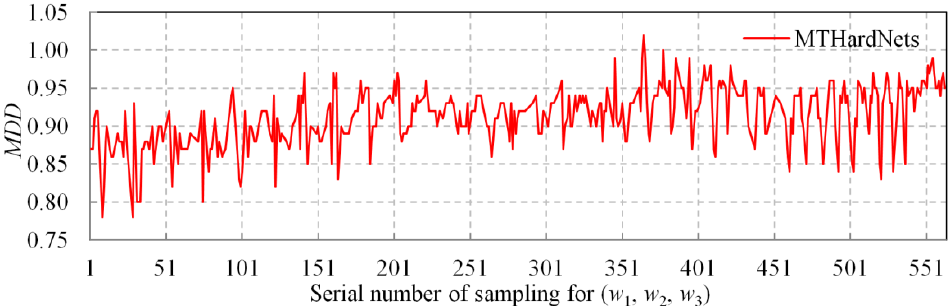
Figure 5. The MDD comparison among 564 groups of ( w 1 , w 2 , w 3 ) with uniform sampling. According to Figure 5, the serial number 366 of ( 0.68, 0.22, 0.10 ) would achieve the highest MDD . Therefore, the Equation (7) can be specifically written